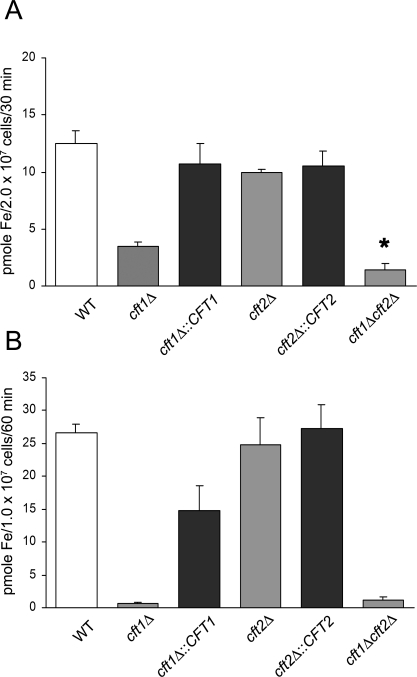
Iron Uptake Is Impaired in the cft1 Mutant(A) Strains were grown in defined low-iron medium and analyzed for iron uptake with 55FeCl3. The results show the average from three experiments with bars representing the standard deviations. The asterisk (*) indicates that the iron uptake for the cft1 cft2 double mutant was statistically different from that of the cft1 mutants (p = 0.007 by a Student t test).(B) The strains indicated were grown in low-iron medium and uptake of 55Fe from transferrin was measured. The results shown are an average from three experiments with bars representing the standard deviations.